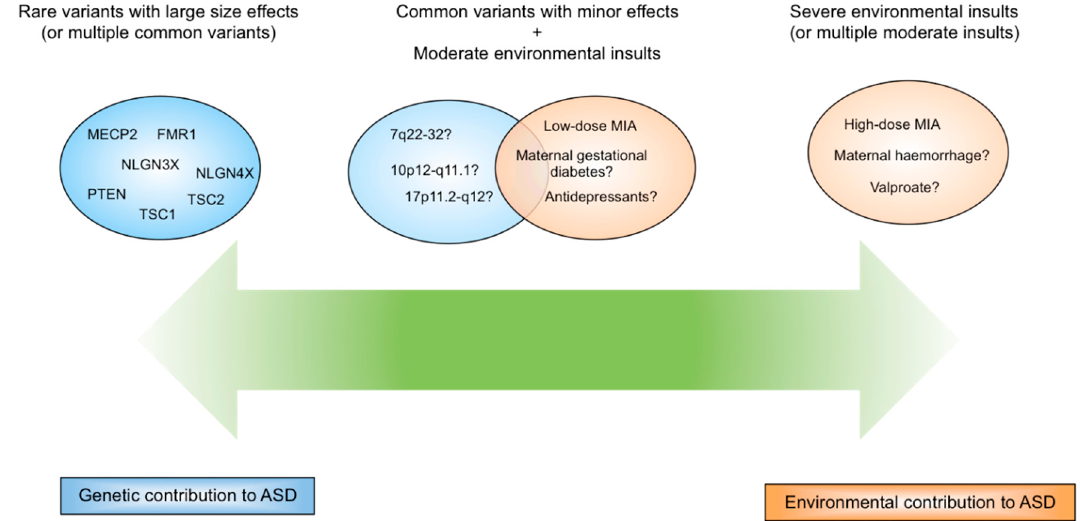
Figure 1. A spectrum of genetic versus environmental contribution in the aetiology of autism spectrum disorder (ASD).